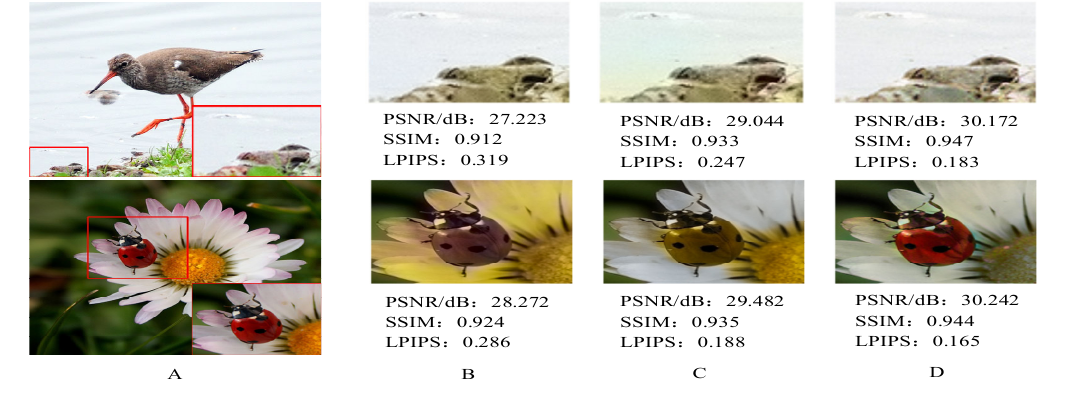
Figure 10. The results of the ablation experiment 3. ( A ) Real image; ( B ) GAN; ( C ) RaGAN; ( D ) Pro-